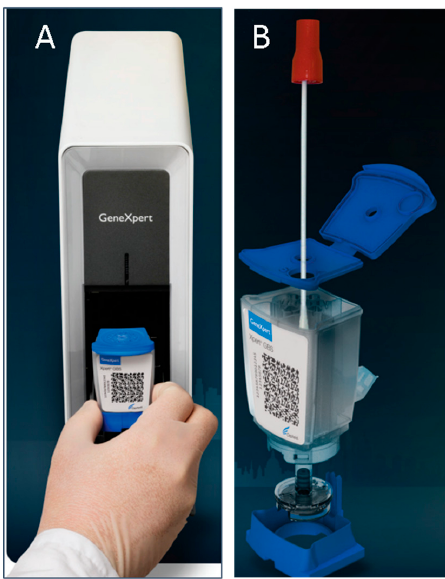
Figure 10. The Cepheid GeneXpert portable platform for qPCR. ( A ) The GeneXpert I model, including a single module able to run one cartridge at a time. ( B ) Exploded view of the disposable GeneXpert cartridge. The upper, bigger part includes the processing chambers where sample preparation occurs.